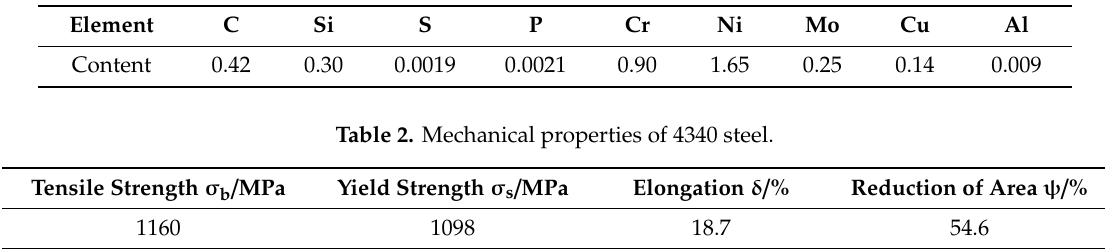
Figure 1. Schematic diagram of AWJP + USRE approach. Table 1. Chemical compositions of 4340 steel.